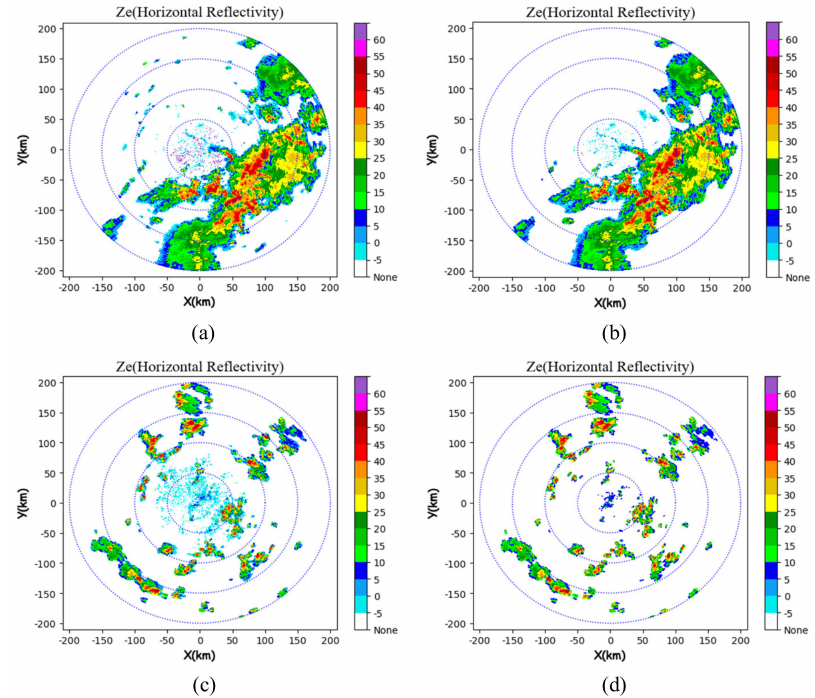
Figure 4. Noise filtering effect in Figure 2 (( a ) represents the original echo image; ( b ) represents the echo image after noise filtering; ( c ) represents the original echo image; ( d ) represents the echo image after ground object clutter filtering).